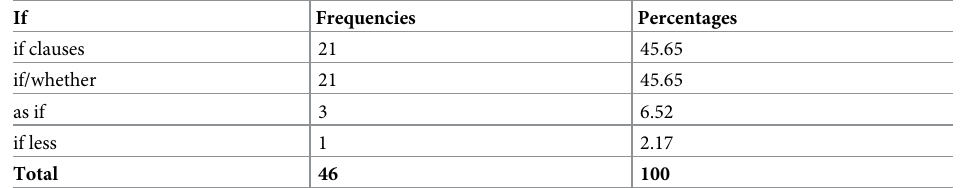
Table 16. Frequencies and percentages of if.